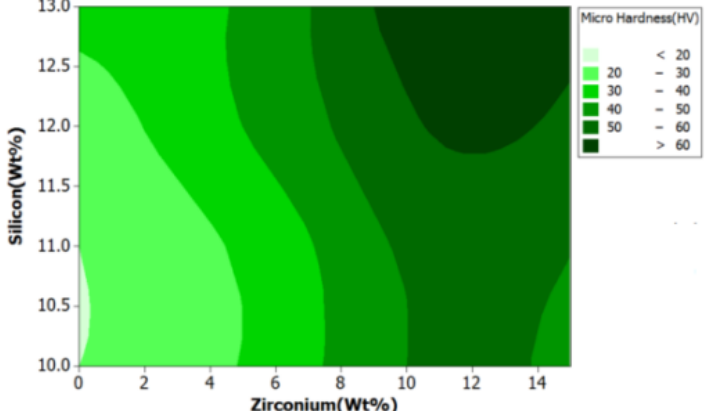
Figure 11. Micro hardness contour plot.